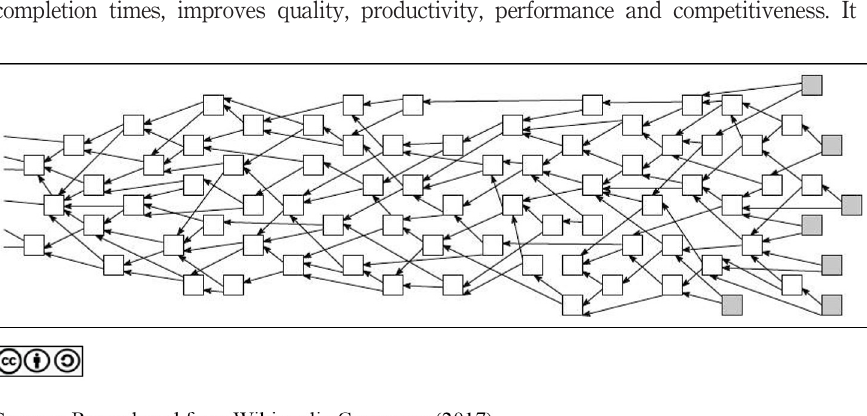
Figure 5. Illustration of the IOTA